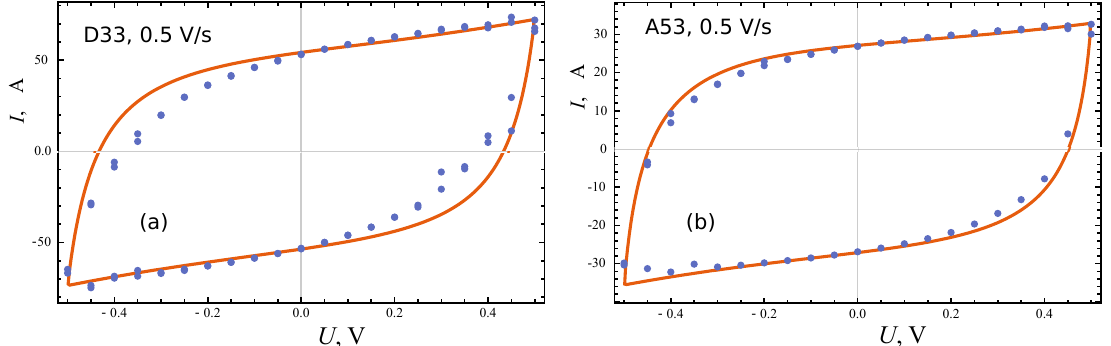
Figure 6. Comparison of measured voltammograms (lines) for PMSC D33 ( a ) and A53 ( b ) with the linear responses predicted by the equivalent circuit model with parameters indicated in Table 1 (points).